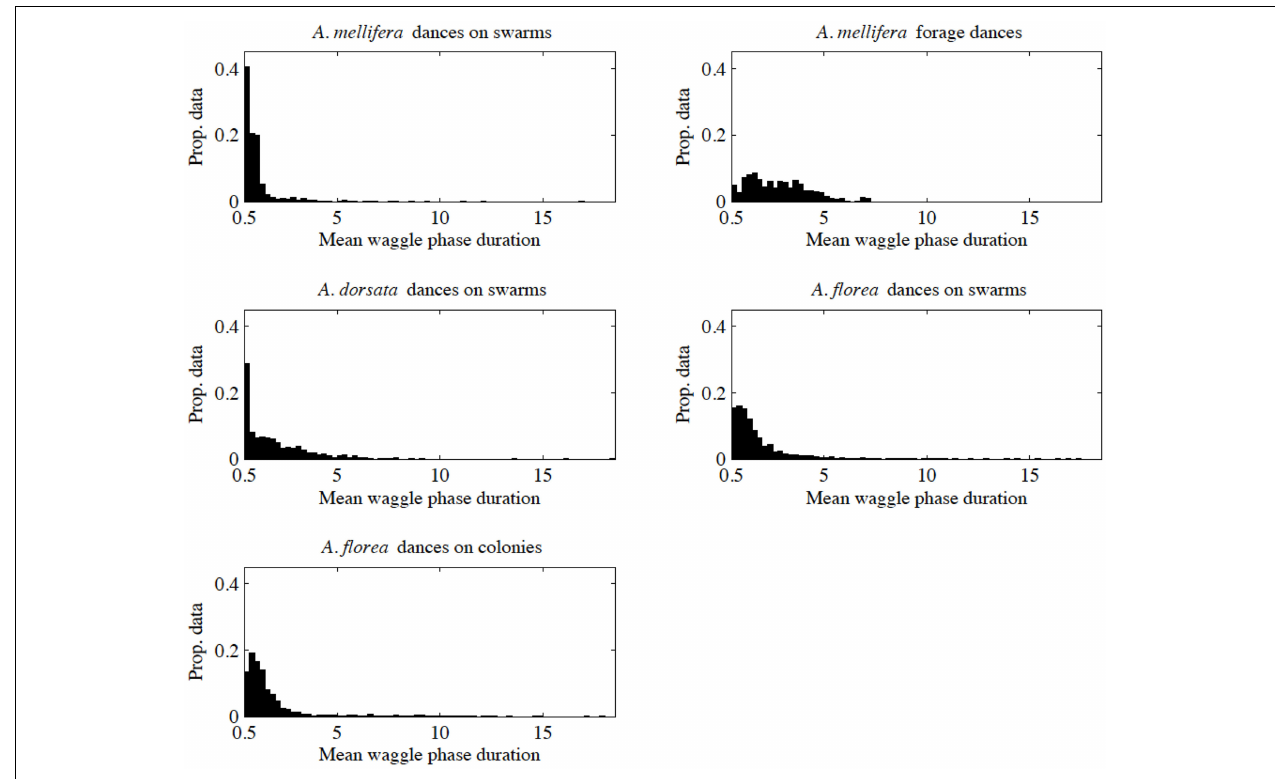
FIGURE 1 | Distribution of data against mean waggle phase duration for our five data sets. We separated data into bins of width